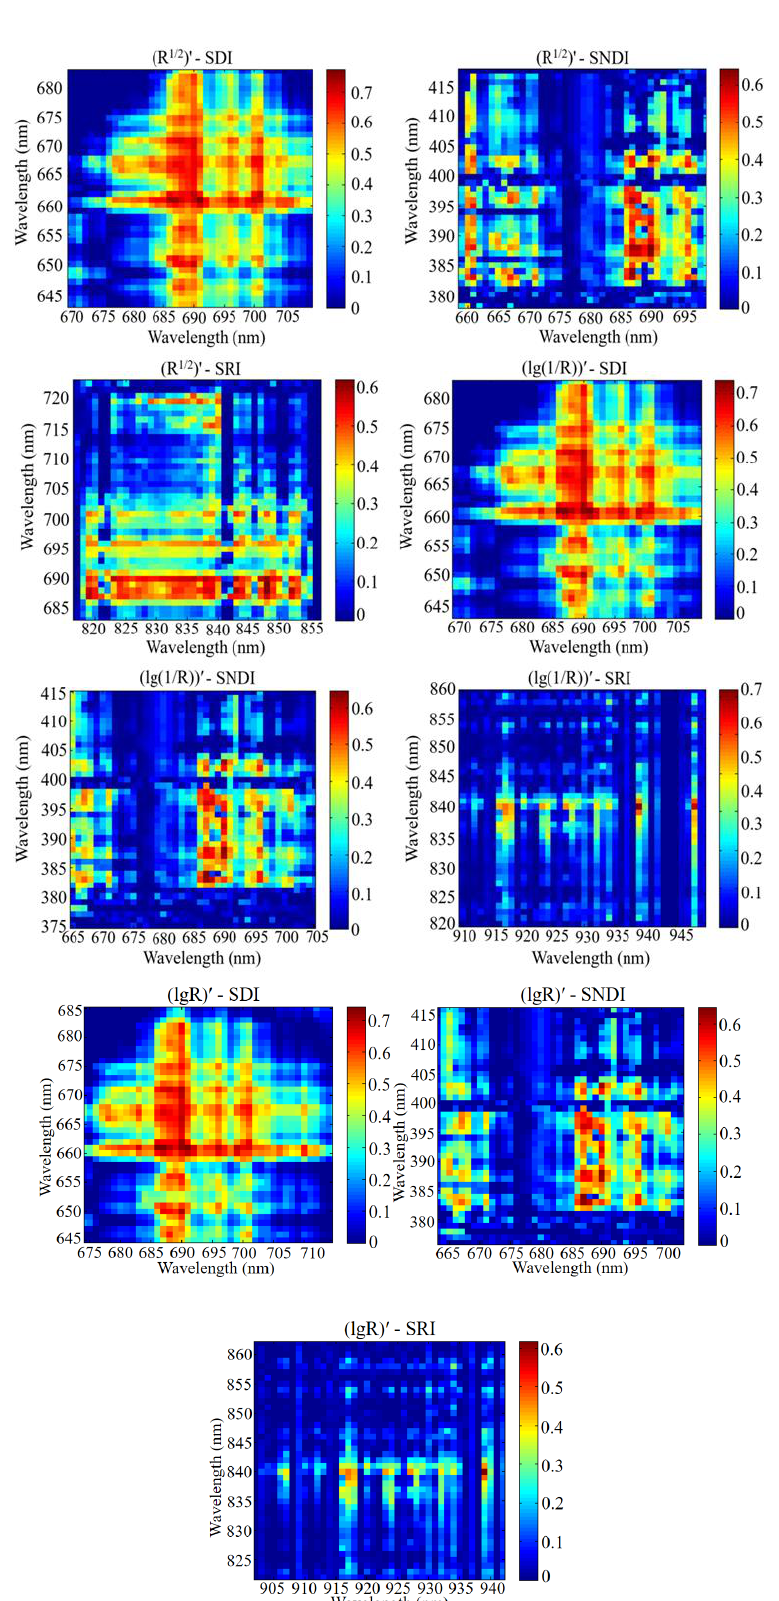
Figure 6. Search for the hyperspectral sensitive band with the combination of spectral transformation and the spectral index. Table 6. Sensitive band combination and correlation coefficients for the combination of spectral transformation and the spectral index.